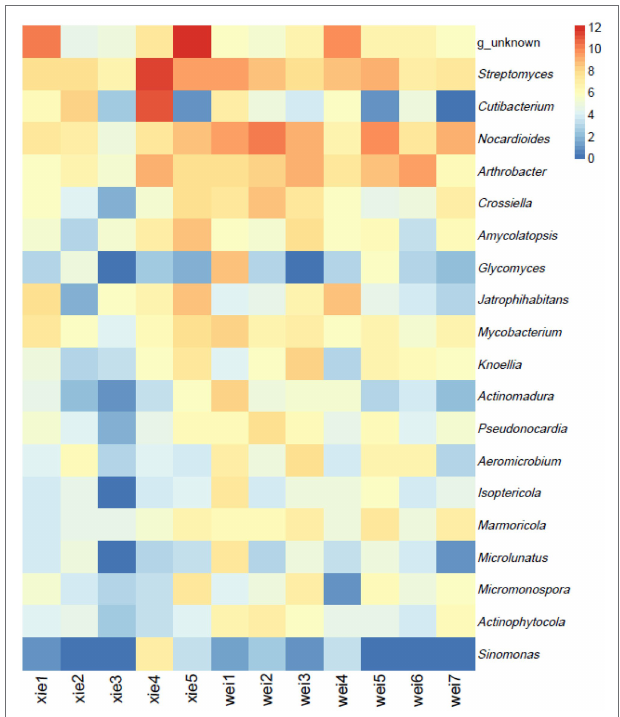
FIGURE 8 | The most predominant genera of Actinobacteria on Weizhou and Xieyang Islands according to an HTS-based analysis. The “blue to red” color gradient indicates the relative abundance of the 20 most predominant genera of Actinobacteria. A deeper red indicates a higher relative abundance, while a deeper blue indicates a lower relative abundance. The values of 0, 2, 4, 6, 8, 10, and 12 indicate the value of relative abundance (the data were normalized and log2-transformed before analysis). “Xie1–Xie5” and “Wei1–Wei7” indicate soil samples from Xieyang and the Weizhou Islands,